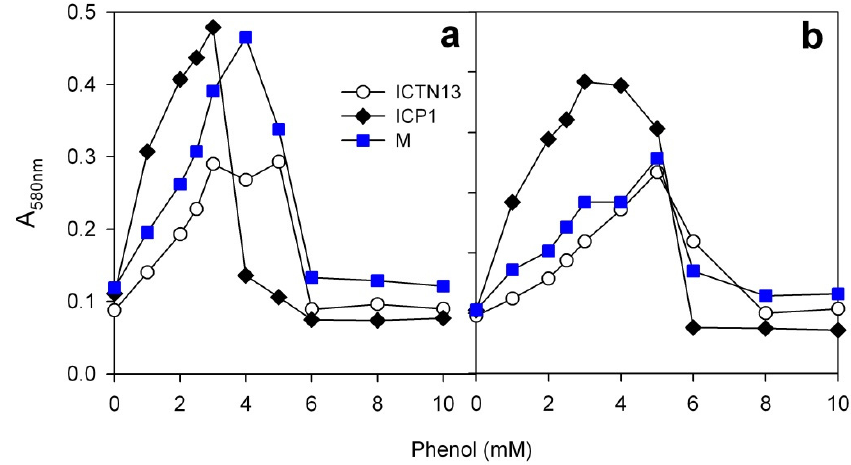
Figure 10. Estimation of the effect of the concentration of phenol on the growth of the strains ICP1 and ICTN13 and their mixture (M) on a minimal medium. The absorbance A 580 nm of the cultures was measured after the incubation of the bacteria at 24 h ( a ) and 48 ( b ) hours at 30 °C. Presented are the results of the three independent experiments each with at least three parallels. A statistical analysis of data is provided in the Supplementary Data S2.